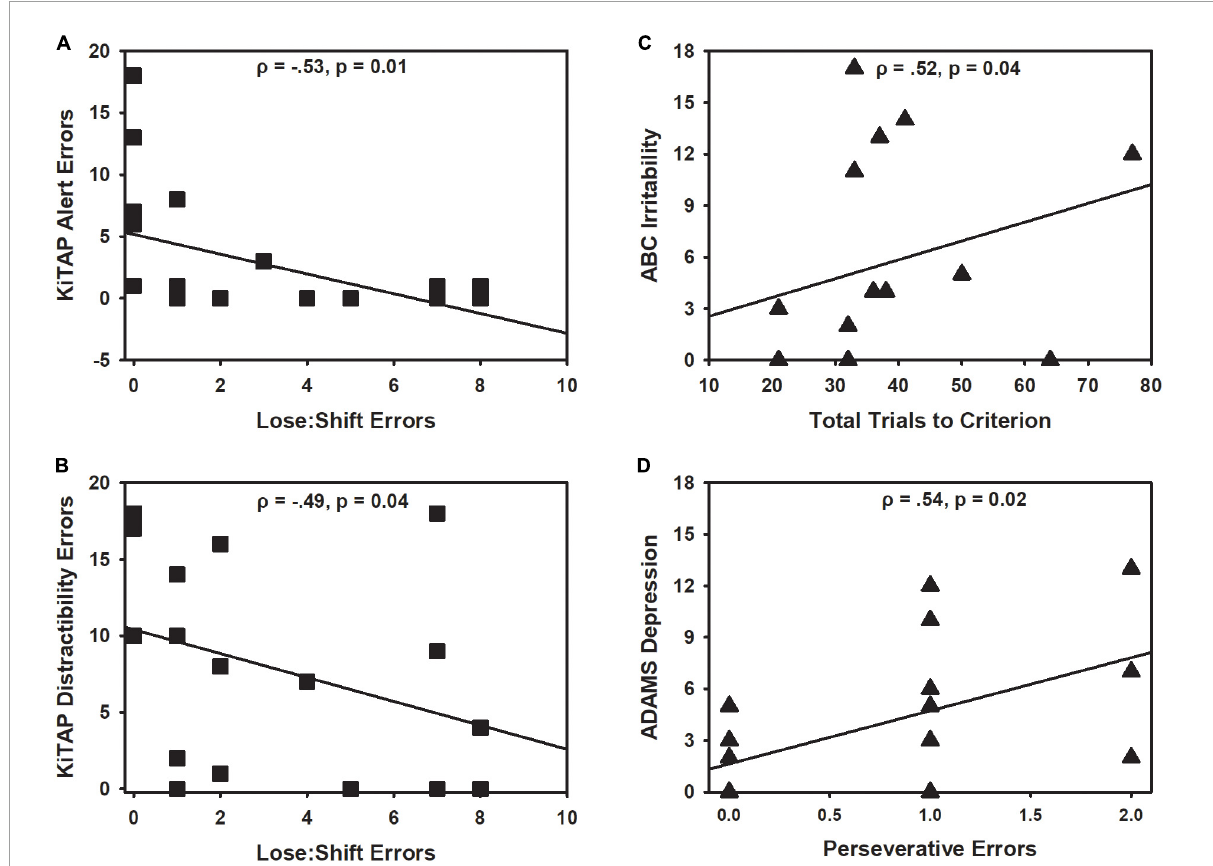
FIGURE5 Correlations with clinical data for males and females with fragile X syndrome (FXS). (A) Increased lose:shift errors during the reversal phase related to fewer anticipation errors during KiTAP Alert task in FXS males (black square). (B) Likewise, lose:shift errors during the reversal phase related to fewer errors during KiTAP Distractibility task in FXS males. (C) In contrast, increased total trials needed to reach criterion related to more severe ABC irritability ratings in FXS females (black triangle). (D) Increased perseverative errors related to more severe ADAMS ratings in FXS females as well. Spearman correlation and p -values provided for each